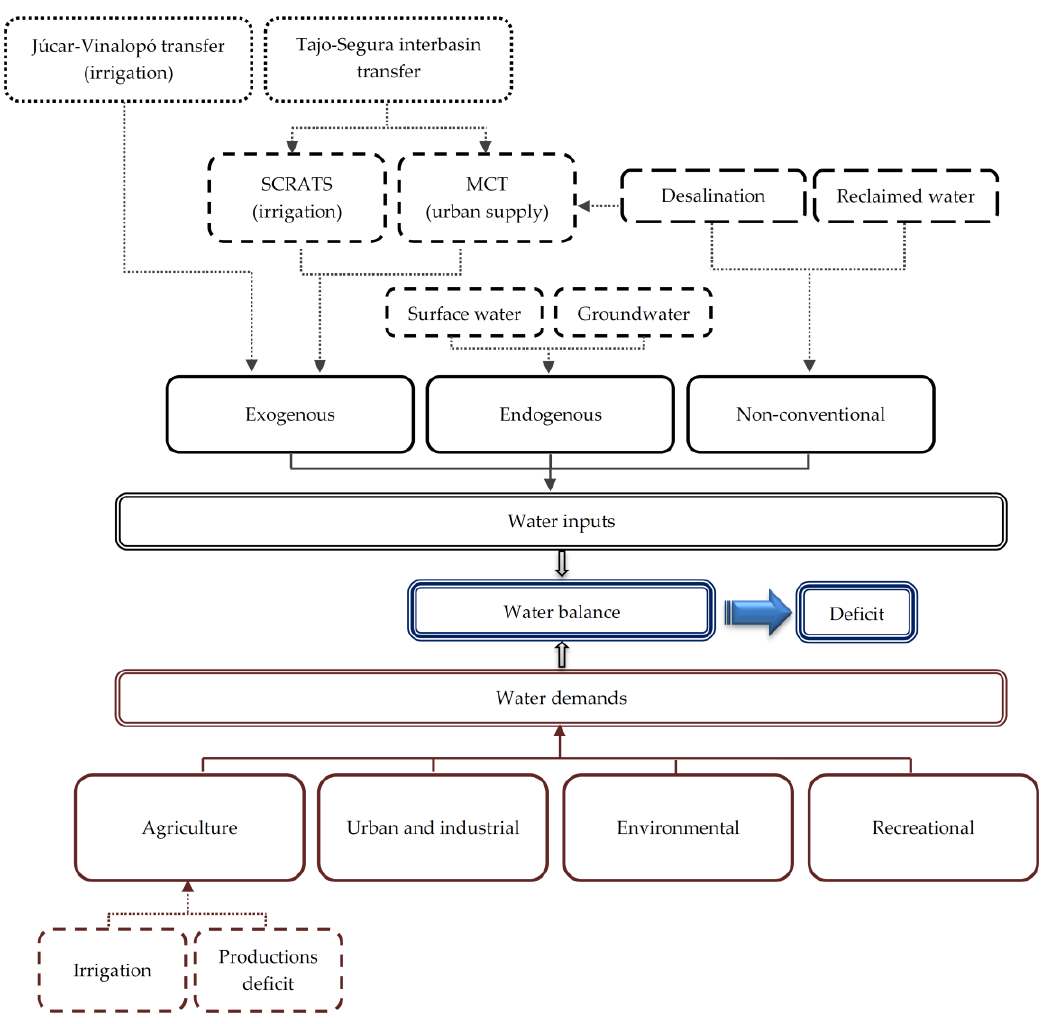
Figure 2. Conceptual model of water balance in the study area. Source: own elaboration.